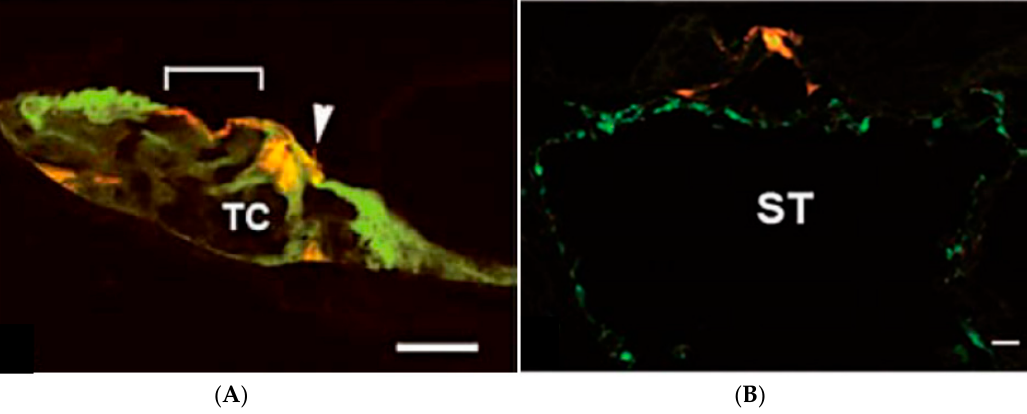
Figure 3. Photomicrographs of histological sections of guinea pig scala media after injection of GFP- SeV/ Δ F ( A ) and after injection via a scala tympani approach ( B ). ( A ) Hair cells and supporting cells from the organ of Corti in an inoculated ear. An inner hair cell is indicated by an arrowhead, and an outer hair cell region is delimited by a bracket. Red, F-actin-stained with rhodamine phalloidin; green, GFP-SeV/ Δ F-transfected cells. Scale bars: 10 μ m. ( B ) Sensory epithelial cells and fibrocytes of the scala tympani. Numerous fibrocytes in the scala tympani are fluorescently labeled. BM, basilar membrane; SL, spiral limb; ST, scala tympani; TC, tunnel of Corti. Scale bars: 100 μ m. (This figure was cited by reference [12] and permitted by S. Karger AG, Medical and Scientific Publishers.)